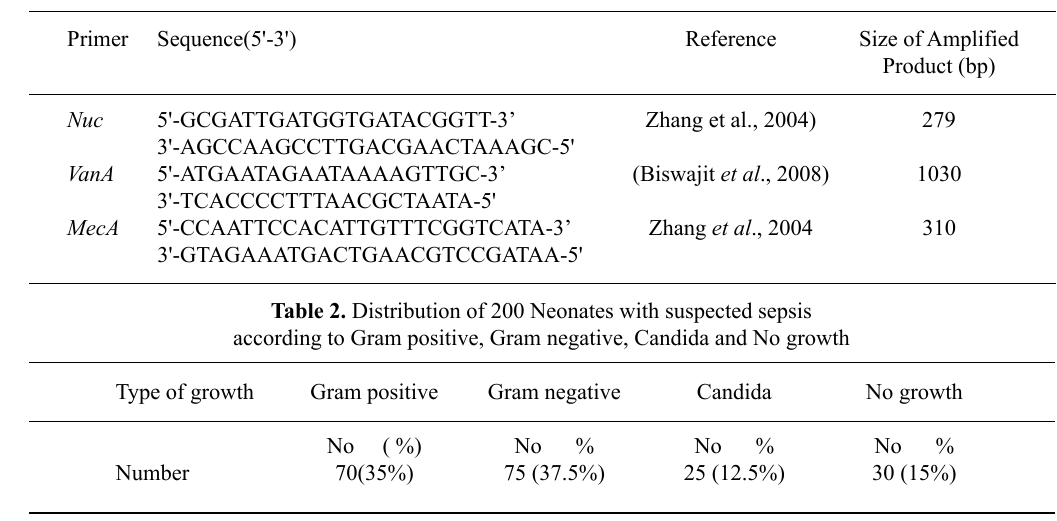
table 1. Primers used for amplification of MecA gene, VanA gene and Nuc gene